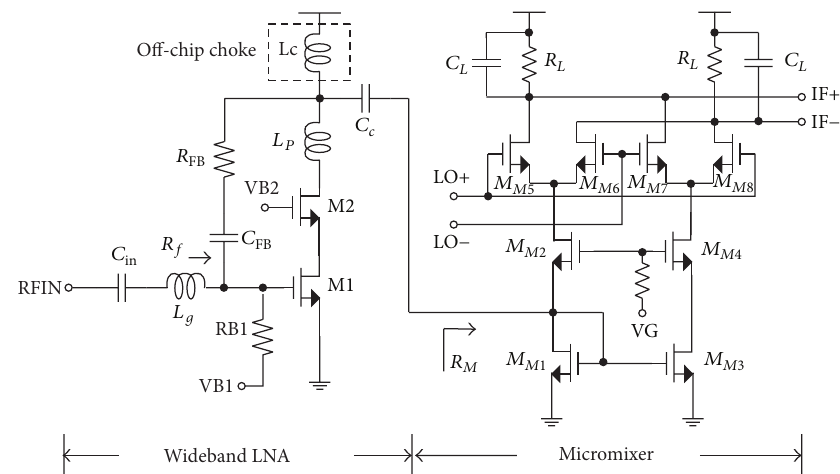
Figure 3: Schematic of proposed receiver front-end.